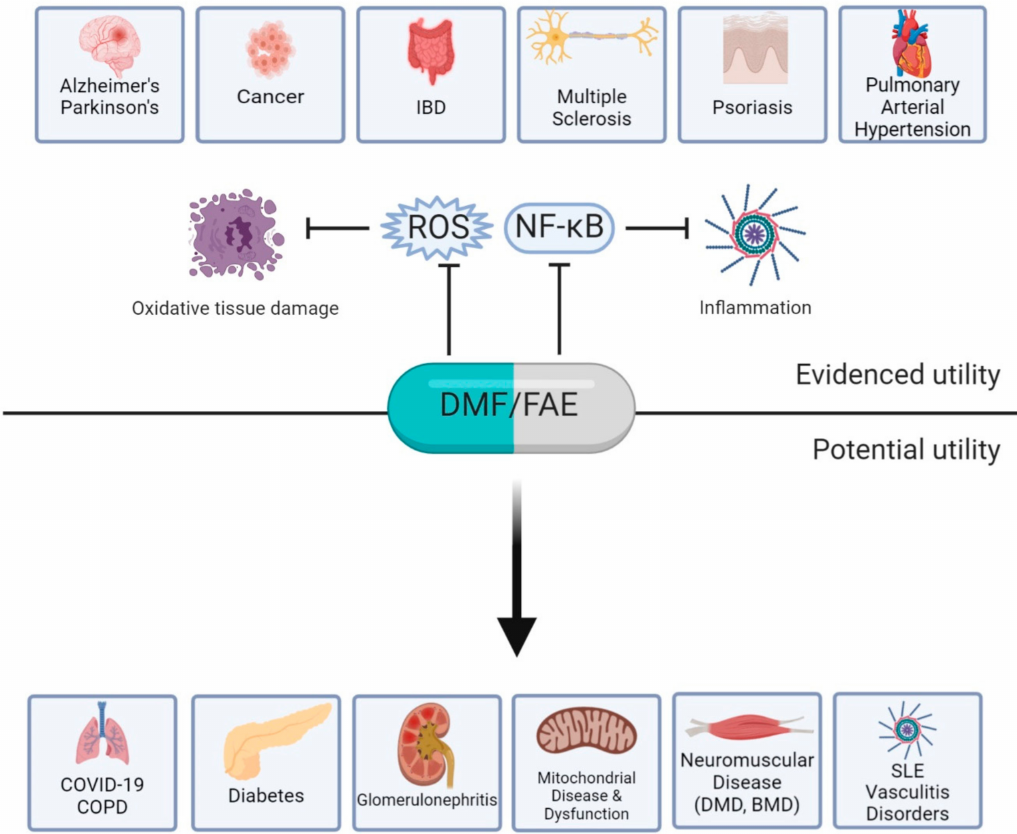
Figure 1. Approved and evidenced utility of dimethyl fumarate (DMF) and fumaric acid esters (FAE) versus potential utility in other diseases that are underscored by oxidative stress and hyperinflammation. DMF and FAE can exert their e ff ects by enhancing cytoprotective and anti-inflammatory responses. This is proposed to lead to the reduction of reactive oxygen species (ROS), which in turn prevents oxidative tissue damage. DMF also inhibits nuclear factor κ -light-chain-enhancer of activated B cells (NF- κ B), which subsequently reduces pro-inflammatory cytokine production and immune cell deviation and ultimately leads to reduced inflammation. BMD: Becker Muscular Dystrophy; COPD: chronic obstructive pulmonary disease; DMD: Duchenne Muscular Dystrophy; IBD: inflammatory bowel disease; SLE: systemic lupus erythematosus. Bar heads = inhibitory e ff ect; Arrow heads = potential beneficial e ff ect. Created with